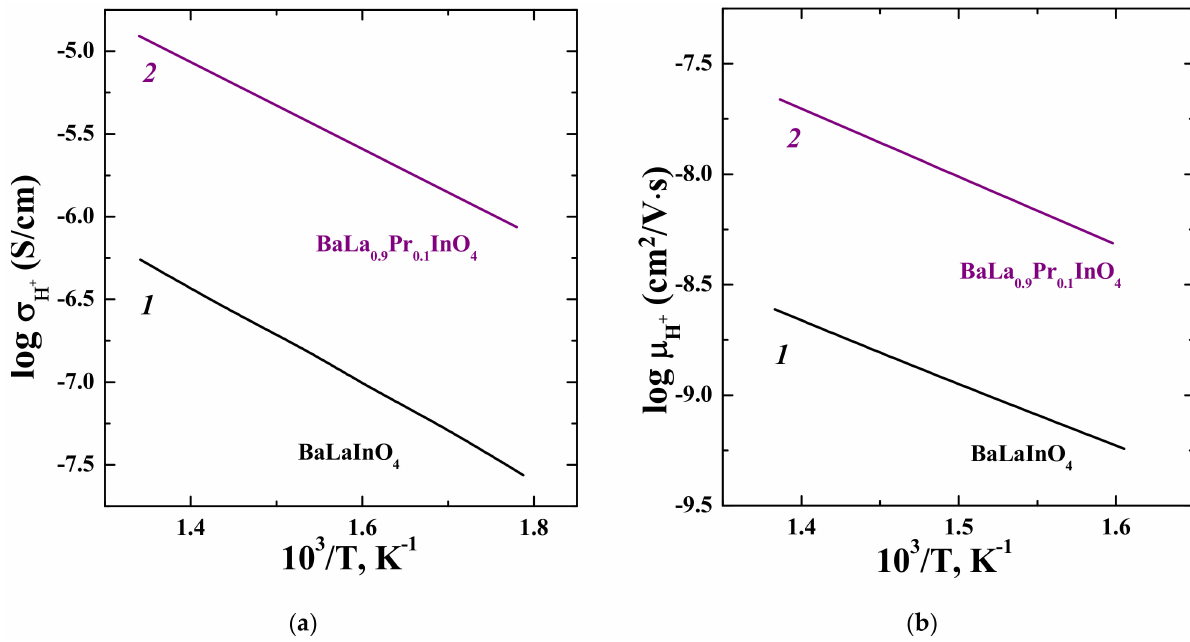
Figure 4. The dependencies of conductivity ( a ) and mobility ( b ) of protons vs. temperature for the compositions BaLa 0.9 Pr 0.1 InO 4 and BaLaInO4